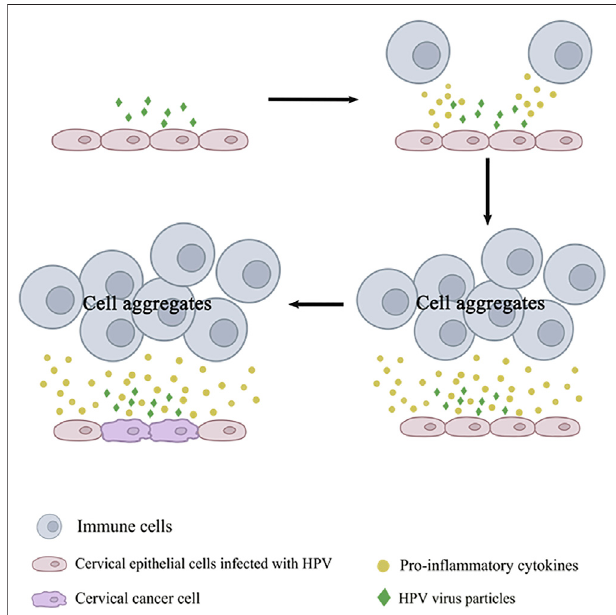
FIGURE 1 | The process by which HPV infected cells becomes cancerous. The process by which HPV infected cells becomes cancerous. HPV virus particles arereleased when HPV infected cells undergo lysis.At this point, immune cells are recruited by virus particles and release pro- in fl ammatory cytokines. In fl ammation will persists if the virus particles are not completely removed in time. This could cause HPV infected cells to become